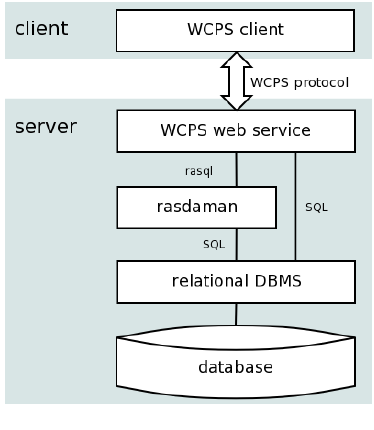
Figure 1. WCPS reference implementation service